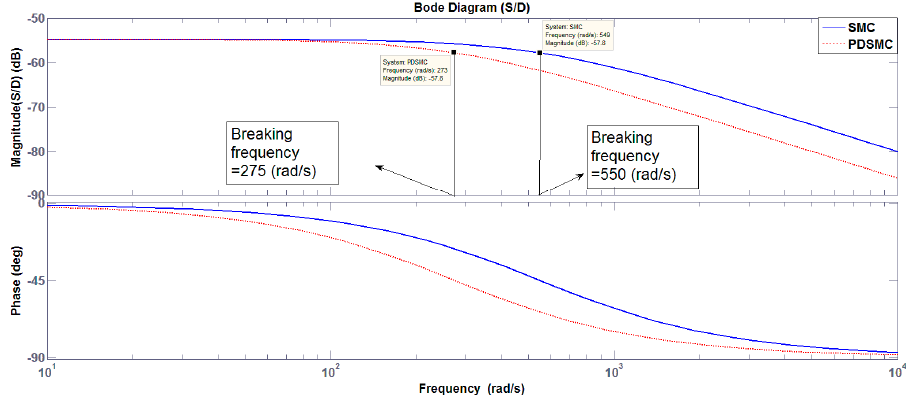
Figure 8. Bode plot of sliding surface over perturbation.